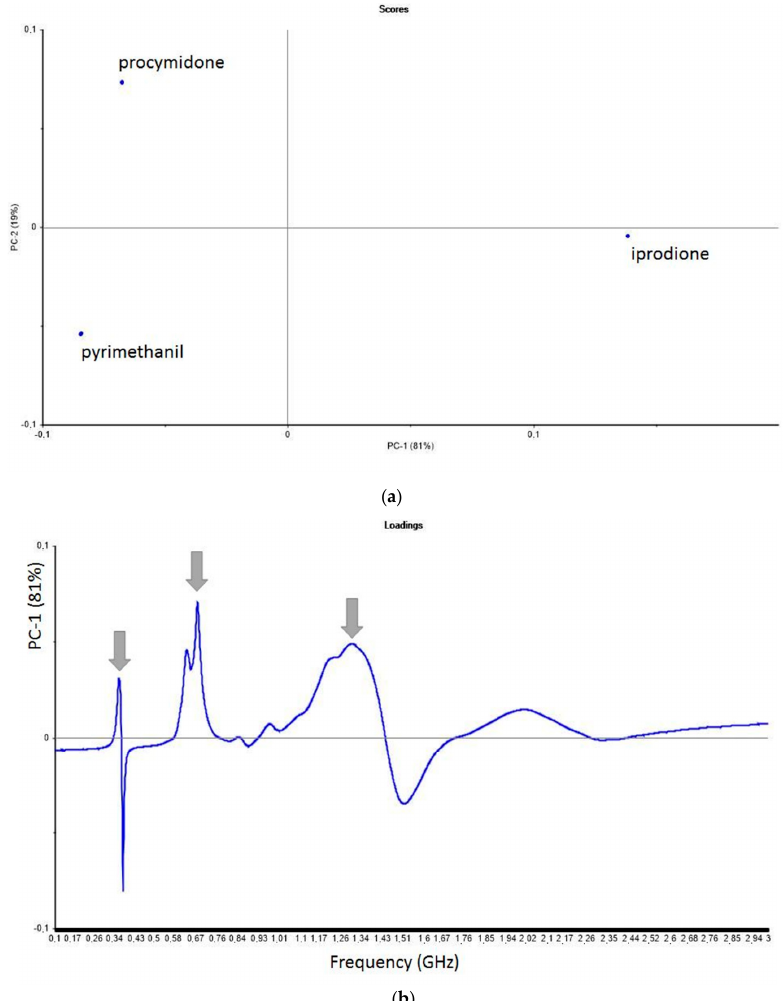
Figure 4. ( a ) PCA scores plot of datasets from the three fungicides at 5 ng L − 1 analyzed with the microwave sensor coupled to MIS in a model wine medium (water/ethanol, 90/10, v / v ). PC1 and PC2 account for 100% of the total variance in the data. ( b ) Loading plot for the first principal component (PC1) of three fungicides datasets at 5 ng L − 1 in the model wine medium (water/ethanol, 90/10, v / v ). Spectra were acquired using the microwave sensor coupled to MIS. Characteristic bands are highlighted by arrows.